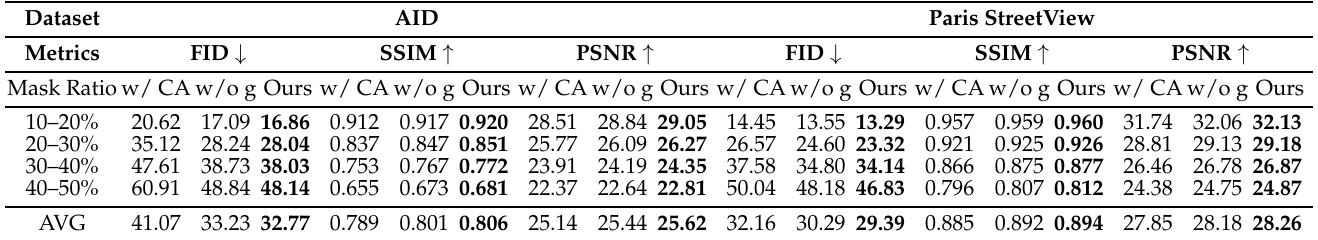
Table 6. Analysis of the MWA module on the AID and Paris StreetView datasets.